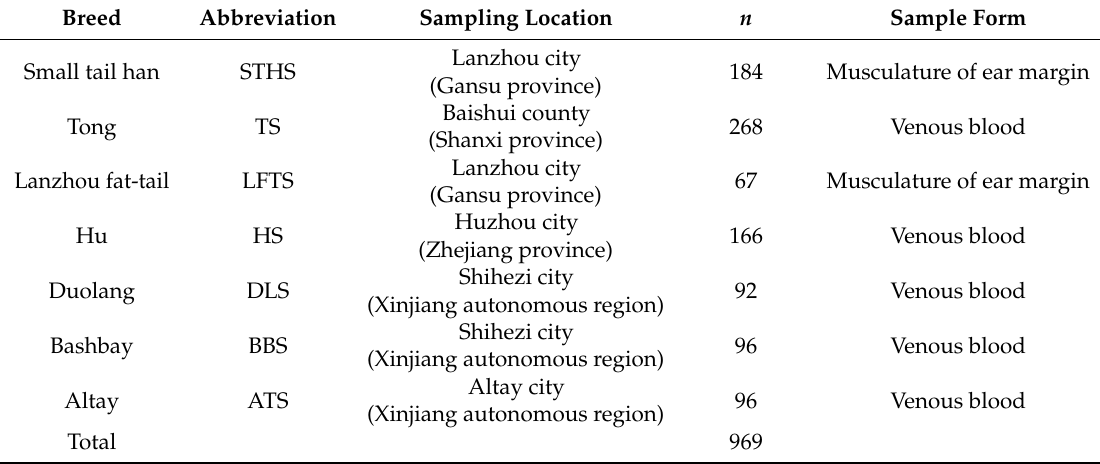
Table 1. Information of seven sheep breeds in this